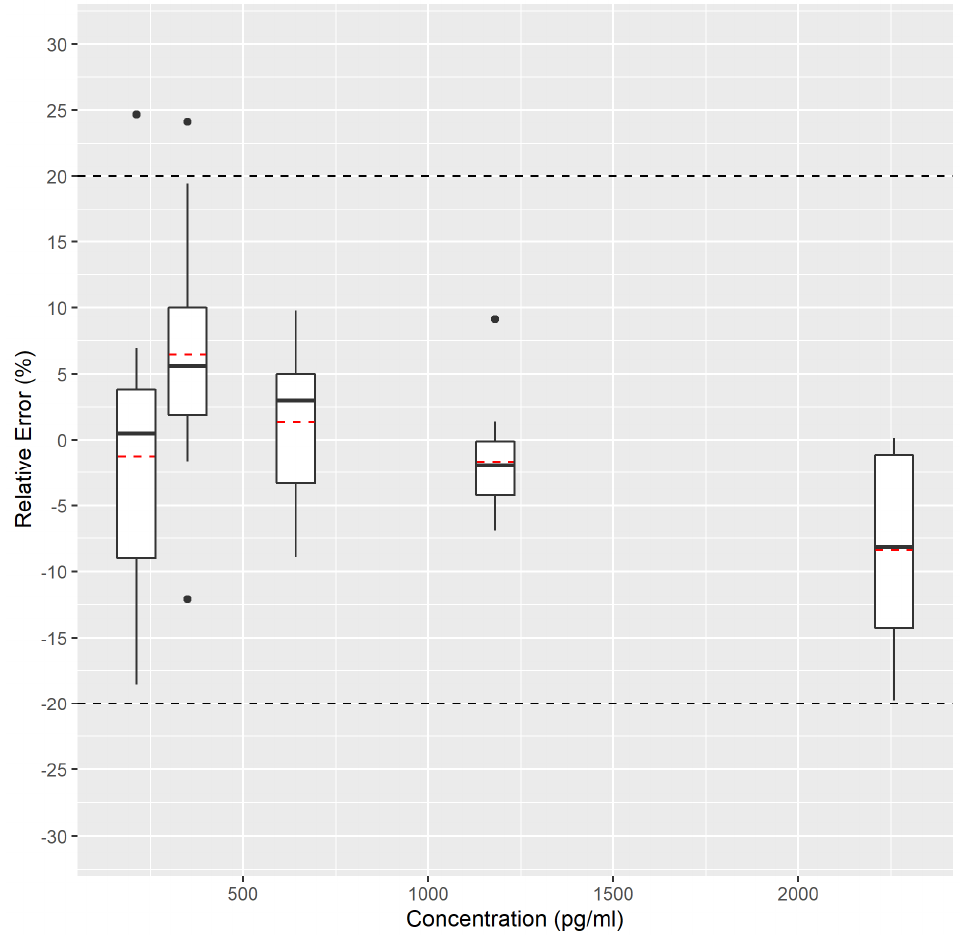
Figure 2. Accuracy profile for MDA analysis in EBC represented in the form of a box-and-whisker plot. The figure denotes the measured relative error compared to the targeted spiked concentration. The black central line represents the median value (50th percentile) whereas the red dashed lines represent the average value. The upper and lower whiskers correspond to the adjacent values as defined by Tukey [42]. Black dots correspond to data points falling outside the adjacent values that can be considered as potential outliers. Theywere plotted separately. The external dashed lines correspond to the acceptance limits (fixed at 20%).